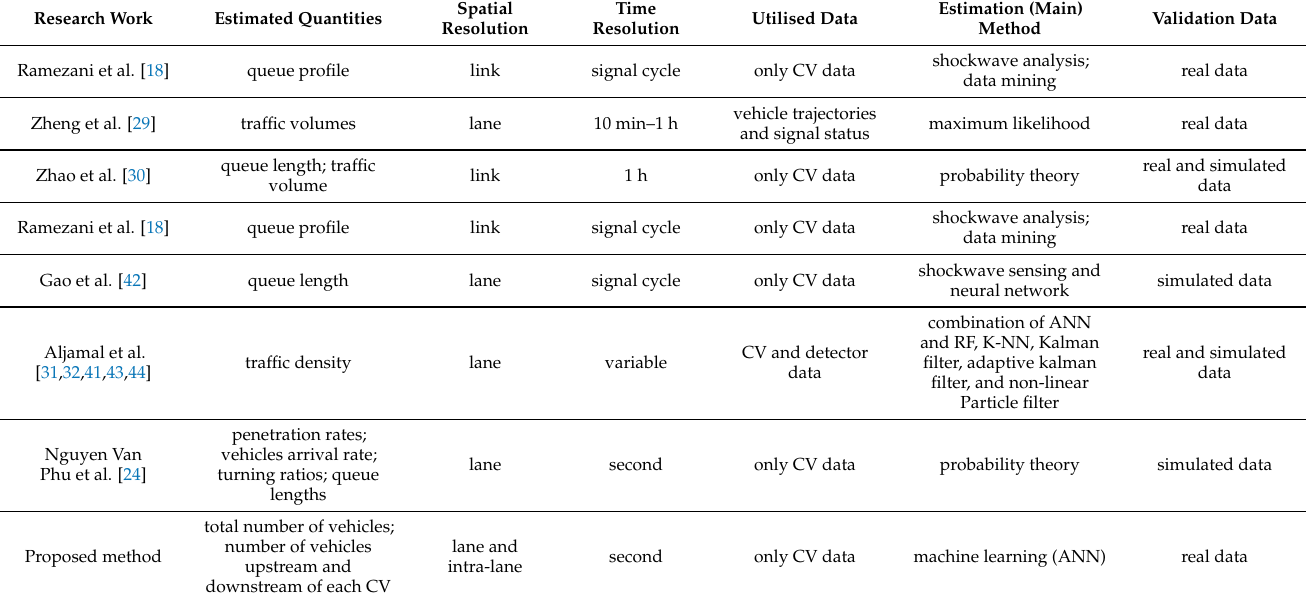
Table 1. Summary of research on traffic state estimation using CV